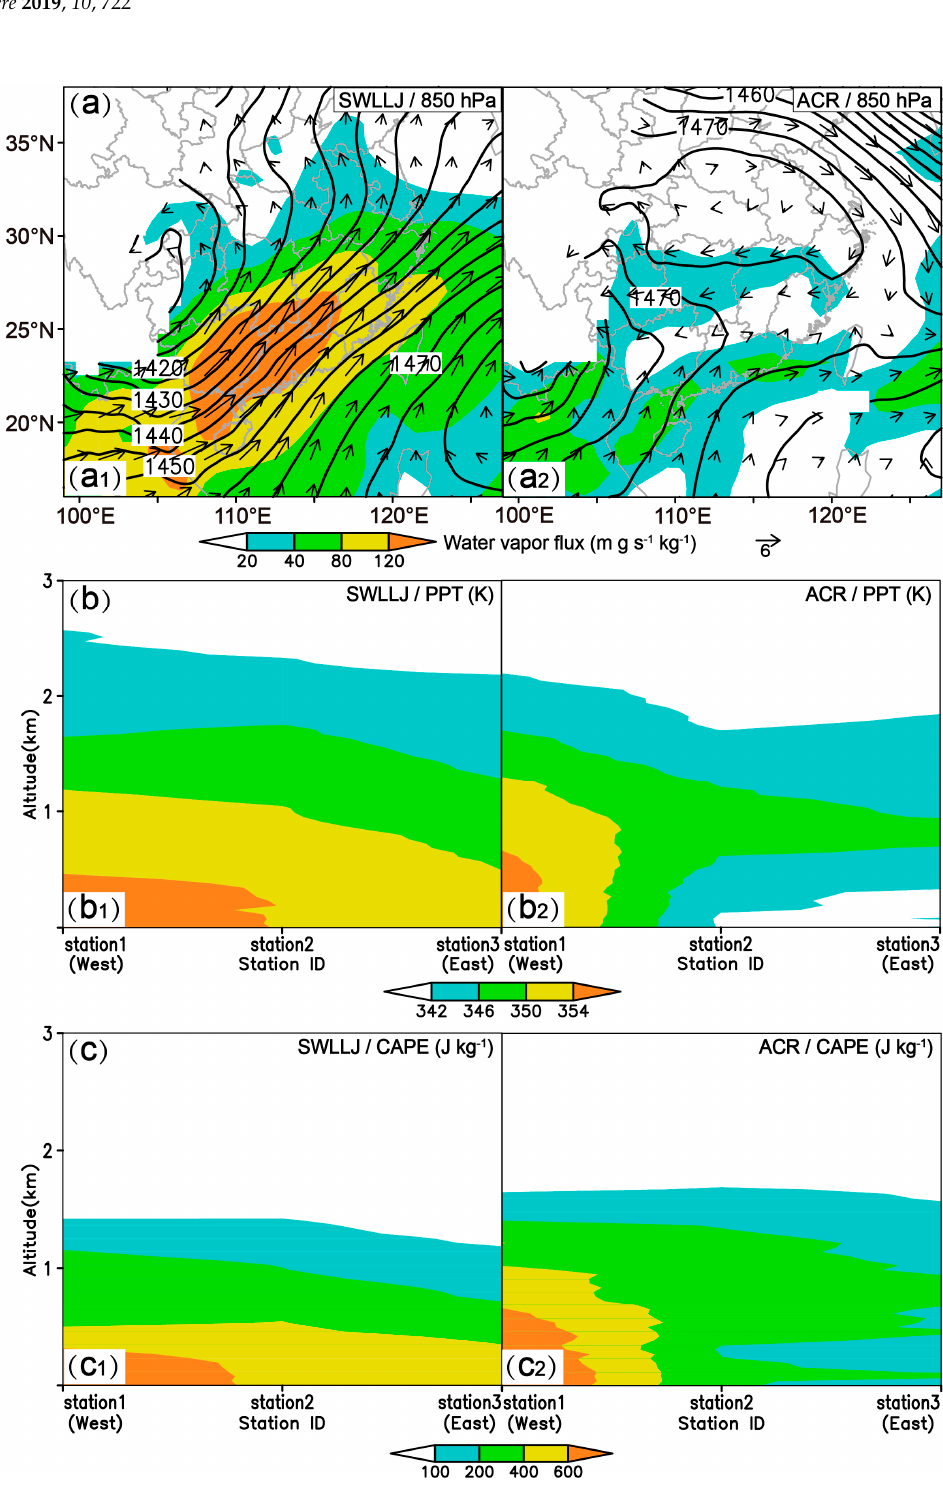
Figure 7. ( a , a 1 and a 2 ) Composite water vapor fluxes at 850 hPa (color-shaded; units: m g s − 1 kg − 1 ), and vertical sections of composite ( b , b 1 and b 2 ) virtual potential temperatures (PPTs; color-shaded; units: K) and ( c , c 1 and c 2 ) convective available potential energies (CAPEs; color-shaded; units: J kg − 1 ) for the OWSRs in the ( a 1 , b 1 and c 1 ) SWLLJ and ( a 2 , b 2 and c 2 ) ACR situations. The composite water vapor fluxes are overlaid with composite geopotential heights (contours; units: gpm) and wind vectors (units: m s − 1 ) at 850 hPa. “station1” indicates the radiosonde station nearby the rainfall location, and “station2” and “station3” indicate the radiosonde stations to the east of “station1” along the orientation of rainfall extension.